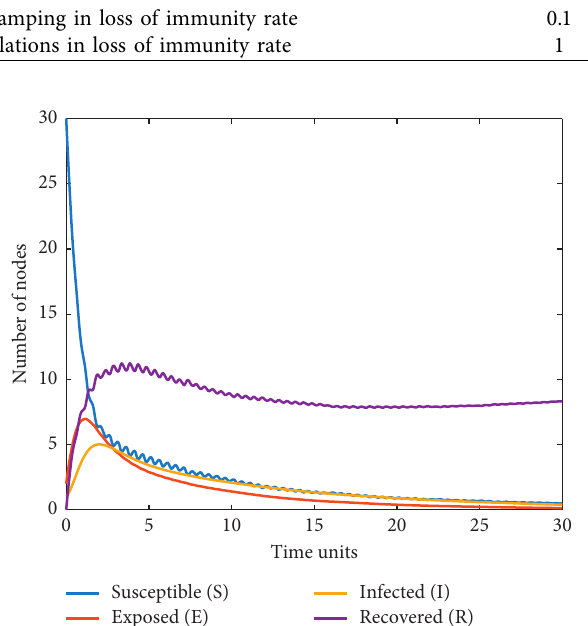
Figure 3: Simulation of the proposed model when applying the initial